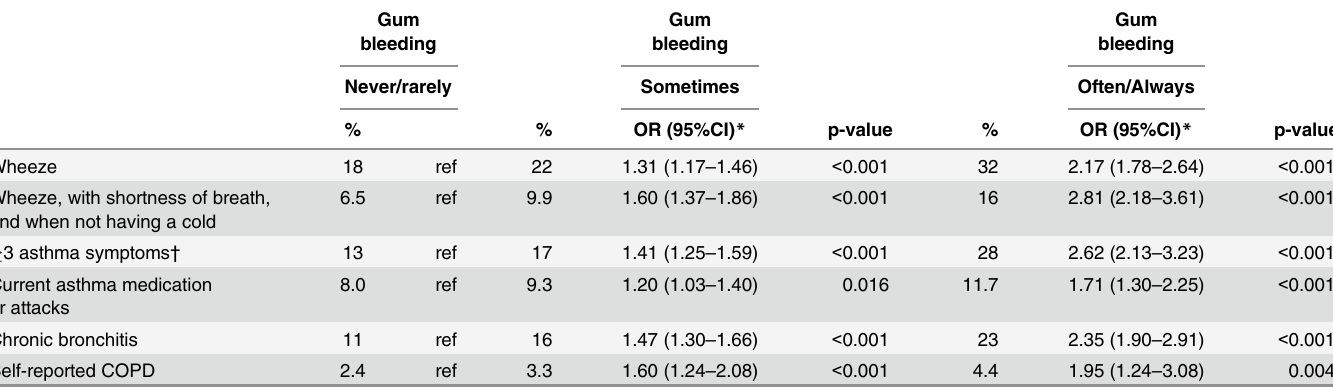
Table 3. Respiratory symptoms, asthma and self-reported COPD as related to frequency of gum bleeding in a population-based study including between 12803 and 13360 persons with complete data (numbers vary slightly between outcomes due to different frequency of missing).